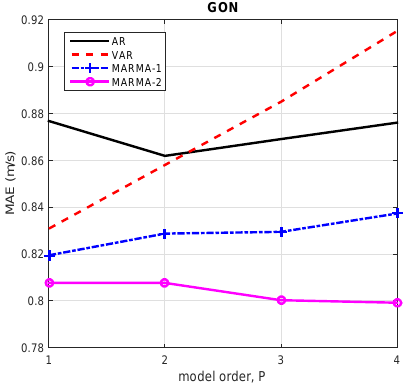
Figure 7. MAE performances of the AR, VAR and MARMA models with respect to model order P when m = 3 (GONEN) and ∆ = 2